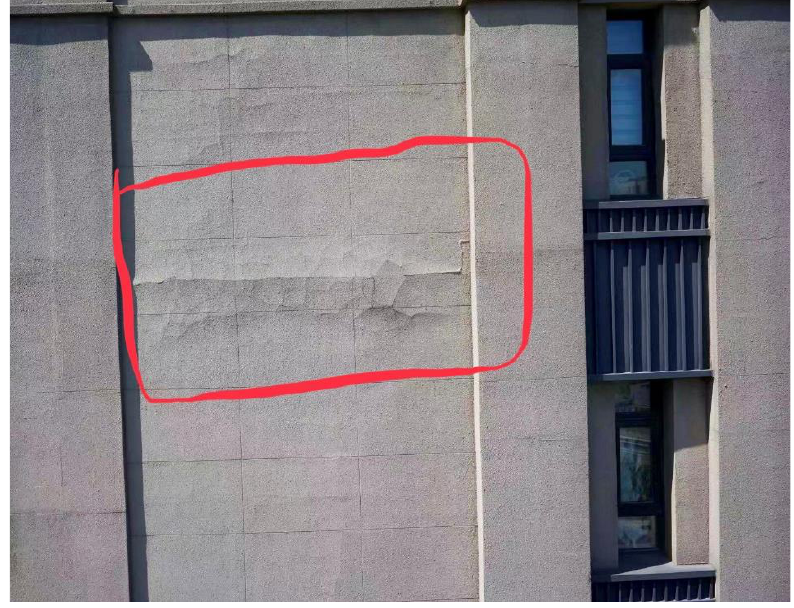
Figure 3: UAV photo of the façade destruction